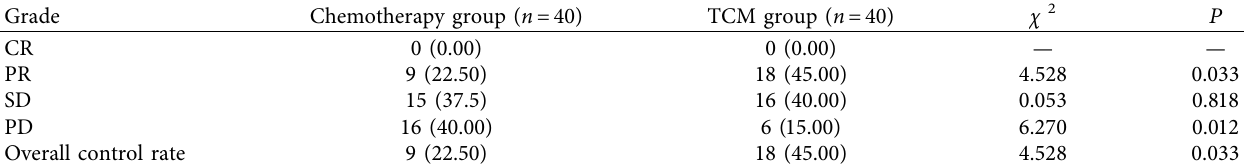
Table 2: Comparison of clinical outcomes between the two groups ( n , %).